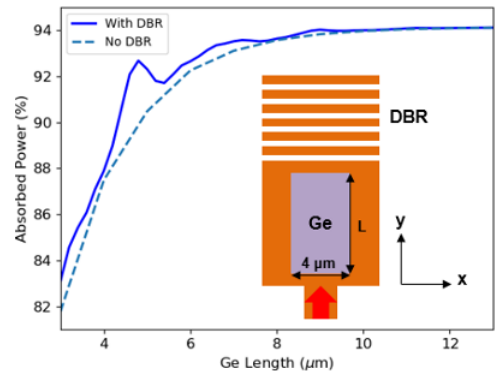
Fig. 1. Absorption of the Ge PD at different lengths. The inclusion of distributed Bragg reflector (DBR) at the exit of the Ge PD enhances the